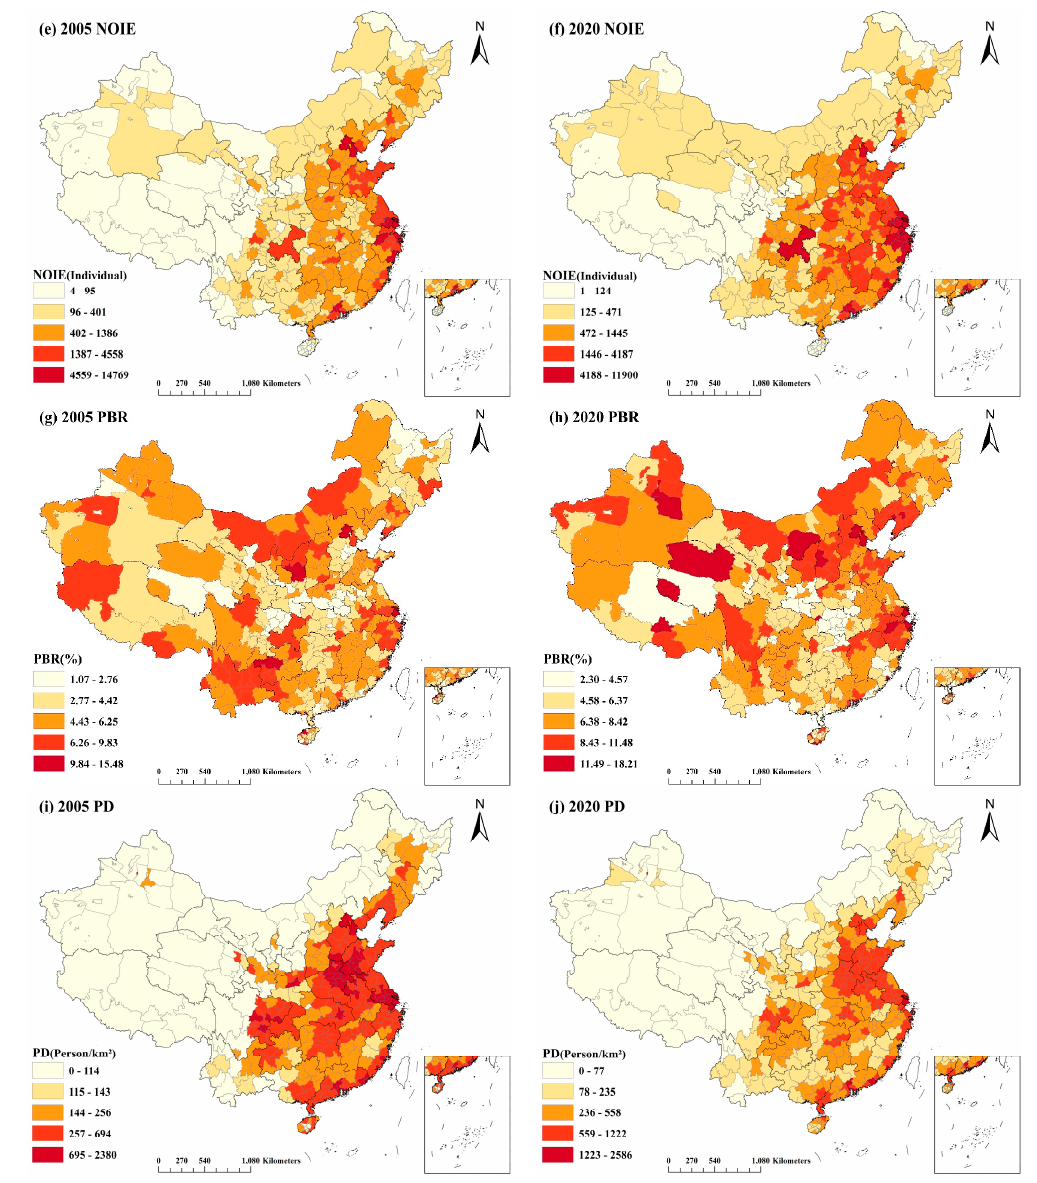
Figure 1. Spatial and temporal distribution of socioeconomic influences in China in 2005 and 2020: ( a ) spatial and temporal distribution of GDP per capita in 2005; ( b ) spatial and temporal distribution of GDP per capita in 2020; ( c ) spatial and temporal distribution of the proportion of secondary in- dustry in 2005; ( d ) spatial and temporal distribution of the proportion of secondary industry in 2020; ( e ) spatial and temporal distribution of the number of industrial enterprise units above the scale in 2005; ( f ) spatial and temporal distribution of the number of industrial enterprise units above the scale in 2020; ( g ) spatial and temporal distribution of the proportion of general public budget reve- nues to GDP in 2005; ( h ) spatial and temporal distribution of the proportion of general public budget revenues to GDP in 2020; ( i ) spatial and temporal distribution of population density in 2005; ( j ) spatial and temporal distribution of population density in 2020.